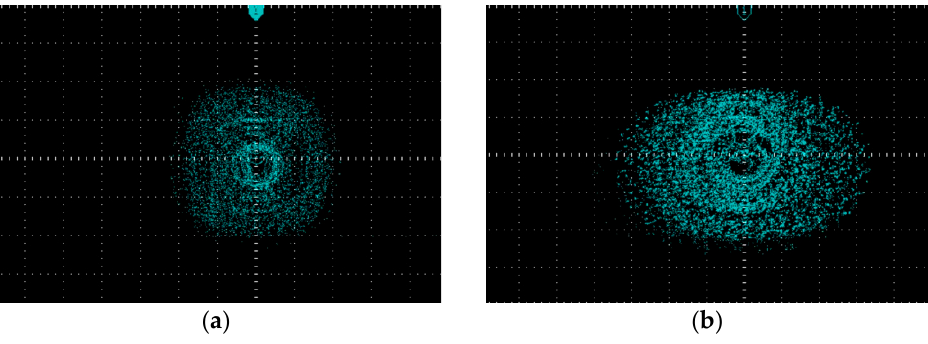
Figure 16. The phase diagram of attractor of DSP, ( a ) a = 2, b = 11, e = 1; ( b ) a = 0.3, b = 11, e = 7.